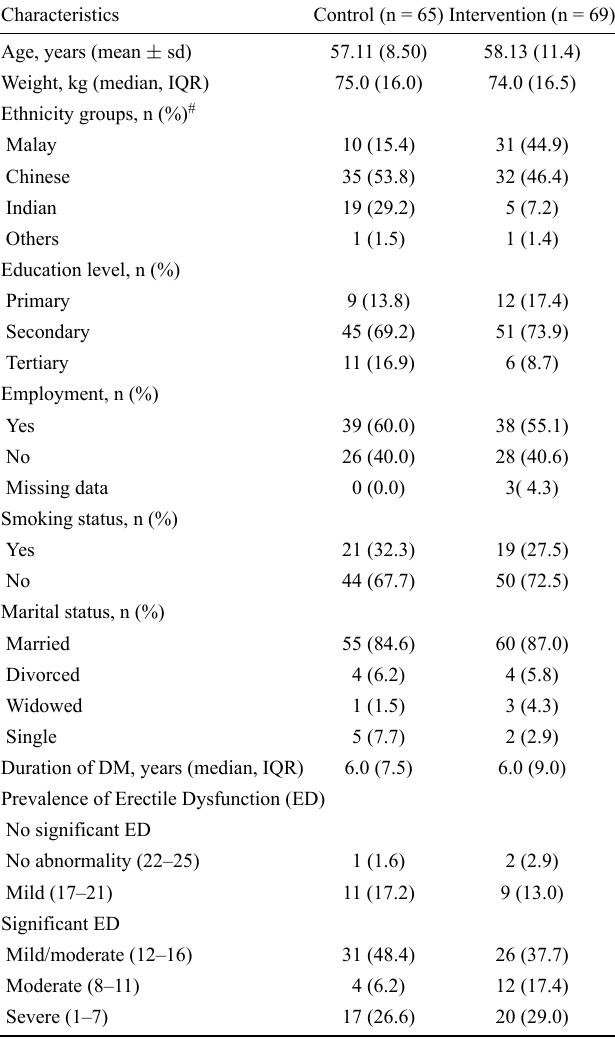
Table 1. Sociodemographic, baseline characteristics and prevalence of erectile dysfunction.